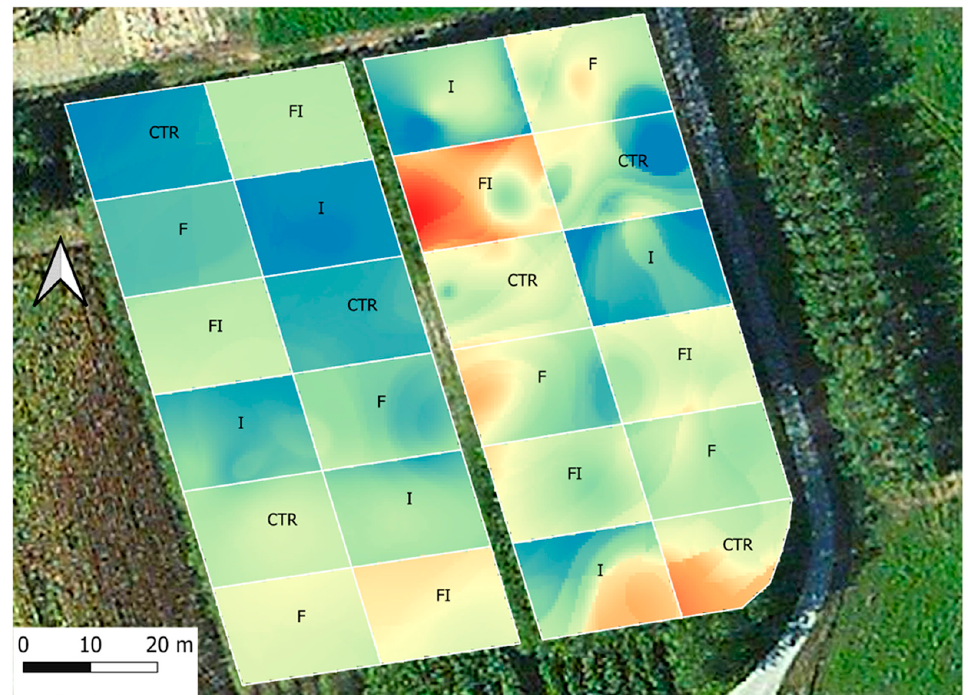
Figure 3. Map of 6-year increments of SOC stock (kg m − 2 ) distinguishing treatments in H-SRC (on the right) and VH-SRC (on the left). The overlapping white grid represents the agronomic treatment model. FI: fertilization and irrigation; I: irrigation; F: fertilization; CTR: control.